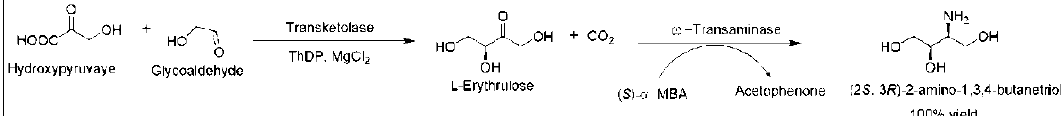
Figure 8. Biocatalytic cascade employing transketolase and ω -TA for the synthesis of amino alcohol (2 S ,3 R )-2-amino-1,3,4-butanetriol (Reprinted from [117], with the permission of John Wiley and Sons). (Reaction conditions: 50 mM substrate, 3.25 U/mL transketolase, 4.8 mM thiamine diphosphate (ThDP), 19.6 mM MgCl 2 , 10 mM ( S )- α -MBA, 27 U/mL ω -TA, 2 mM PLP, Tris-HCl buffer (100 mM, pH 9.0), R.T.).